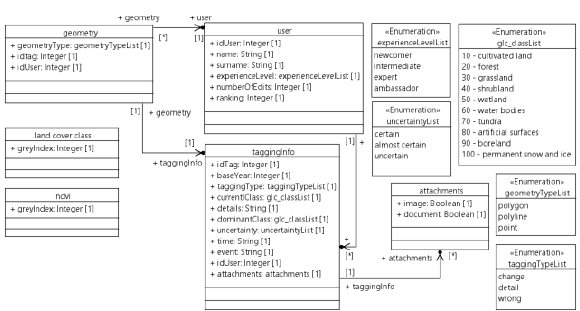
Figure 1. UML (Unified Modelling Language) schema of the data structure for visual tools